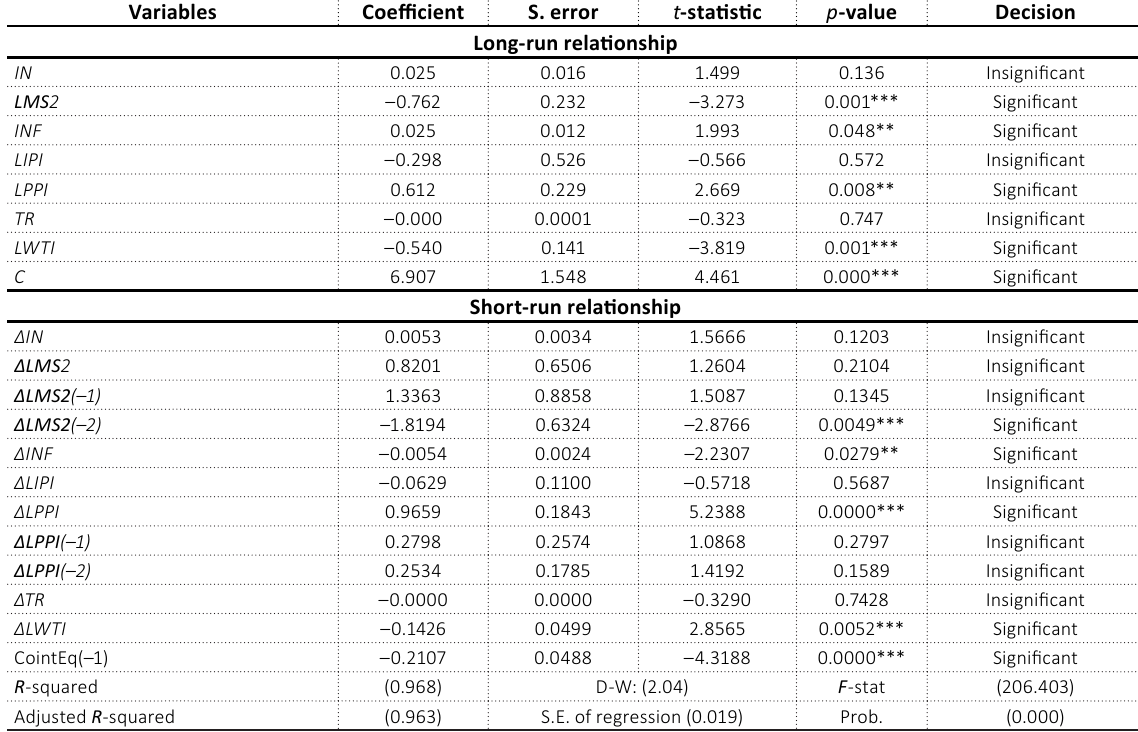
Table 6. Long-run and short-run